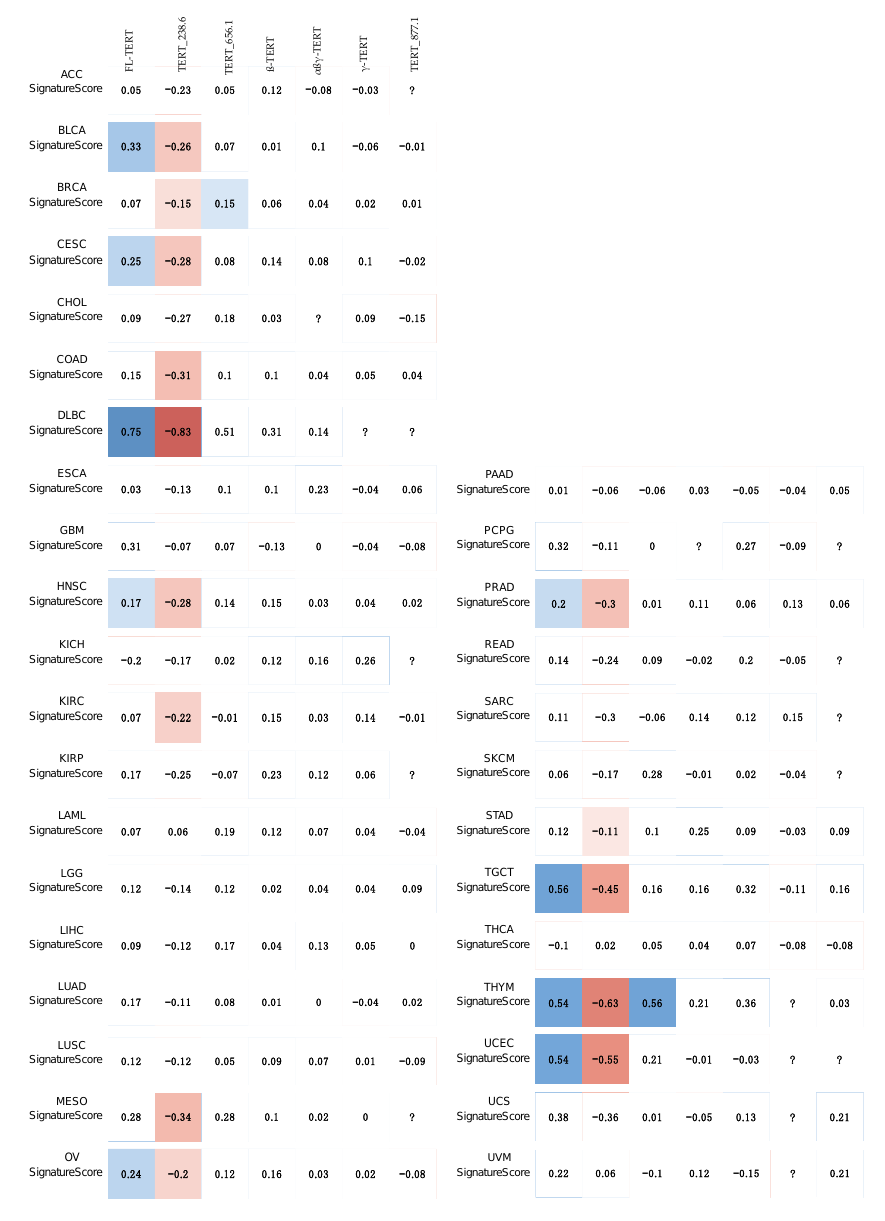
and TERT_238.6 expression, but not with FL-TERT expression (Figure S7). Seeing as these cancer types had the highest total TERT expression and TERT_238.6 was the predominant isoform in most samples, this relationship may simply be reflecting one of total TERT expression and telomere re-lengthening. No other correlations between TERT isoform expression and relative telomere length were observed (Figures S7–S12).